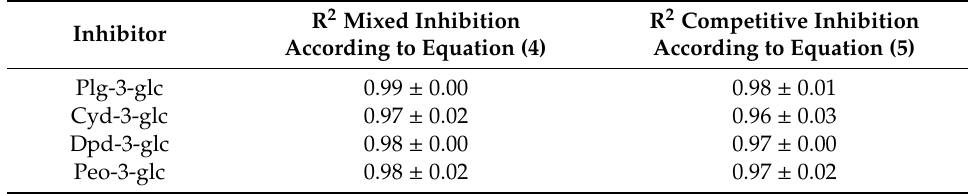
Table A4. Coefficient of determination for the fits based on a mixed and pure competitive inhibition for anthocyanin-3-glycosides.